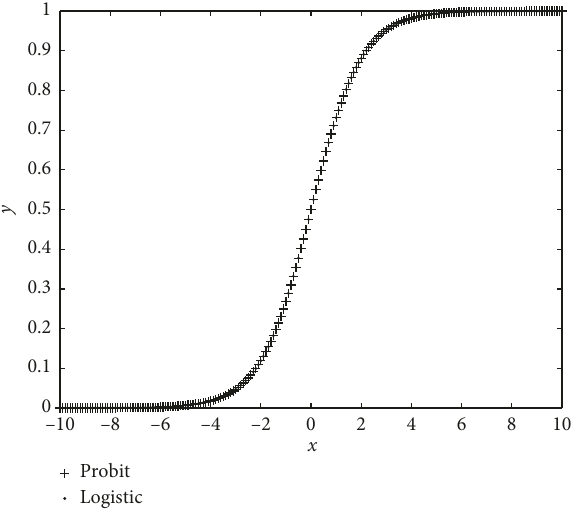
Figure 6: Comparison between the probit model and logistic model ( σ 2 � 1).